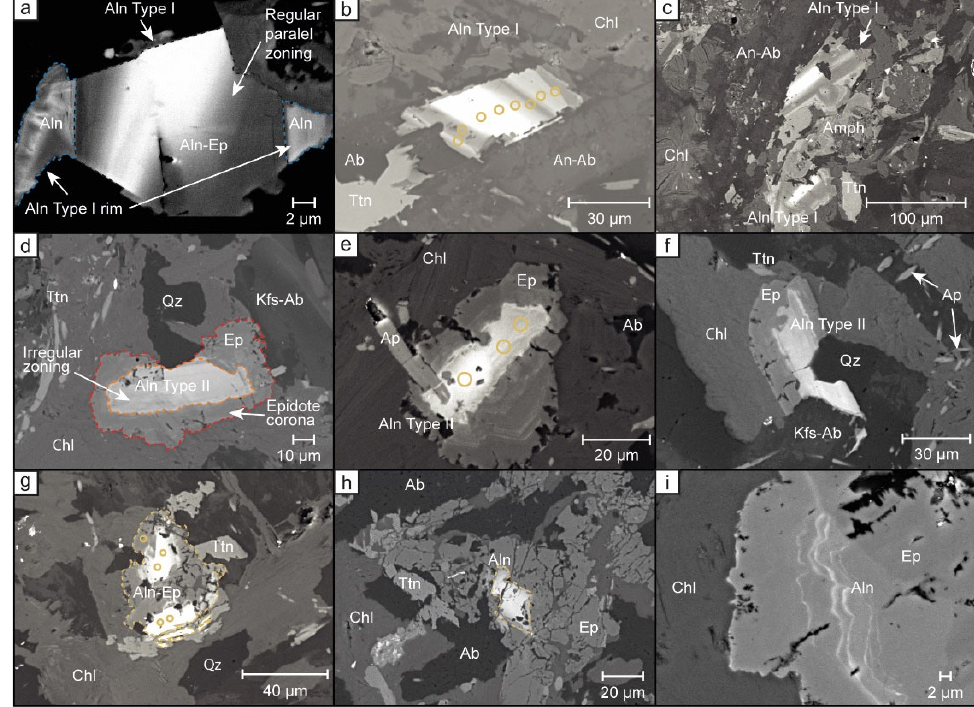
Figure 2. Back ‐ scattered electron images representative of the morphological diversity found in allanite–epidote composite grains from Les Guilleries spessartite dykes. ( a – c ) Allanite Type I present ‐